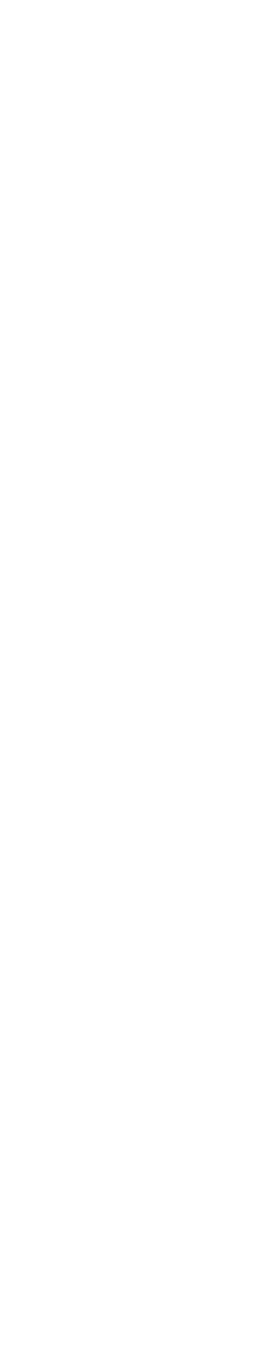
that rs3750965 is a protective genetic marker against cancer at a global level and various subtypes of cancer, including melanoma, mesothelial and soft tissue cancer, and prostate cancer. We detected downregulation of TPCN2 expression in skin that is not sun-exposed (suprapubic) in carriers of the homozygous variant rs3750965 in GTEx. We speculate that there exists an association of this genetic variant with a decreased risk of cancer at a global level, and MM and MS at a local level, due to a decrease in TPCN2 expression that has been shown to be functionally expressed in different types of cancer, using the Human Protein Atlas. Huang et al. observed that TPC2 is overexpressed in oral squamous cell carcinoma cell lines 25 . In our study, we identi fi ed a signi fi cant association of the GG genotype in rs3750965 with a higher risk of malignant neoplasms of the lip, oral cavity, and pharynx, and we are not able to speculate about the effect of this genotype on channel expression/activity in human oral tissues because of lack of data. We believe that TPC2 has distinct roles in various processes, stages, and types of cancers. We also found that carriage of TPCN2 rs3750965:GG/GA is associated with an increased risk of cancer recurrence susceptibility in patients with prostate cancer and rectal cancer (GG OR: 1.07, 95% CI: 0.94 – 1.22, P = 0.018, GA OR: 1.4, 95% CI: 1.05 – 1.85, P value = 0.0199*, respectively, vs. A/A), indicating the possibility of utilising this genetic variant to predict cancer recurrence in patients with prostate and rectal cancer. rs72932540 is a genetic variant located upstream of the TPCN2 TSS on GRCh38: 11:69,154,575. The distance from the variant to the TSS of TPCN2 is 105,643 Kb 9,35 . This genetic variation at close proximity to TPCN2 might in fl uence the expression levels of TPC2 and thereby tumour development. We found that rs72932540:GA was associated with an increased general risk of cancer susceptibility (OR: 1.07, 95% CI: 1.05 – 1.09, P = 4.51e − 10***, vs. A/A) and a higher risk of developing breast cancer, MM, and rectal cancer (OR: 1.1, 95% CI: 1.05 – 1.16, P = 7.2e − 05***, OR: 1.15, 95% CI: 1.042 – 1.26, P value = 0.00512**, OR: